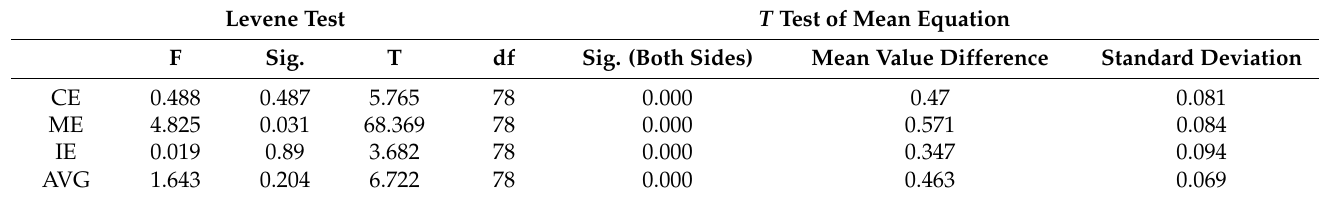
Table 1. Results of eggshell-thickness t tests.